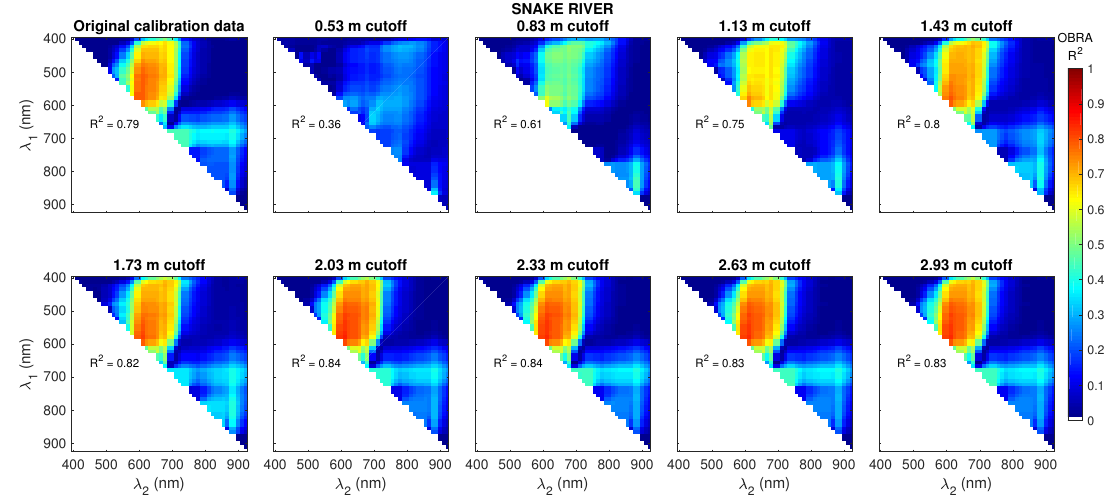
Figure 5. Optimal Band Ratio Analysis (OBRA) matrix based on spectra extracted from the Snake River hyperspectral image for the original field data from the hybrid wading/acoustic Doppler current profiler (ADCP) survey, followed by OBRA matrices for a series of cutoff depths from OBRA of Progressively Truncated Input Depths